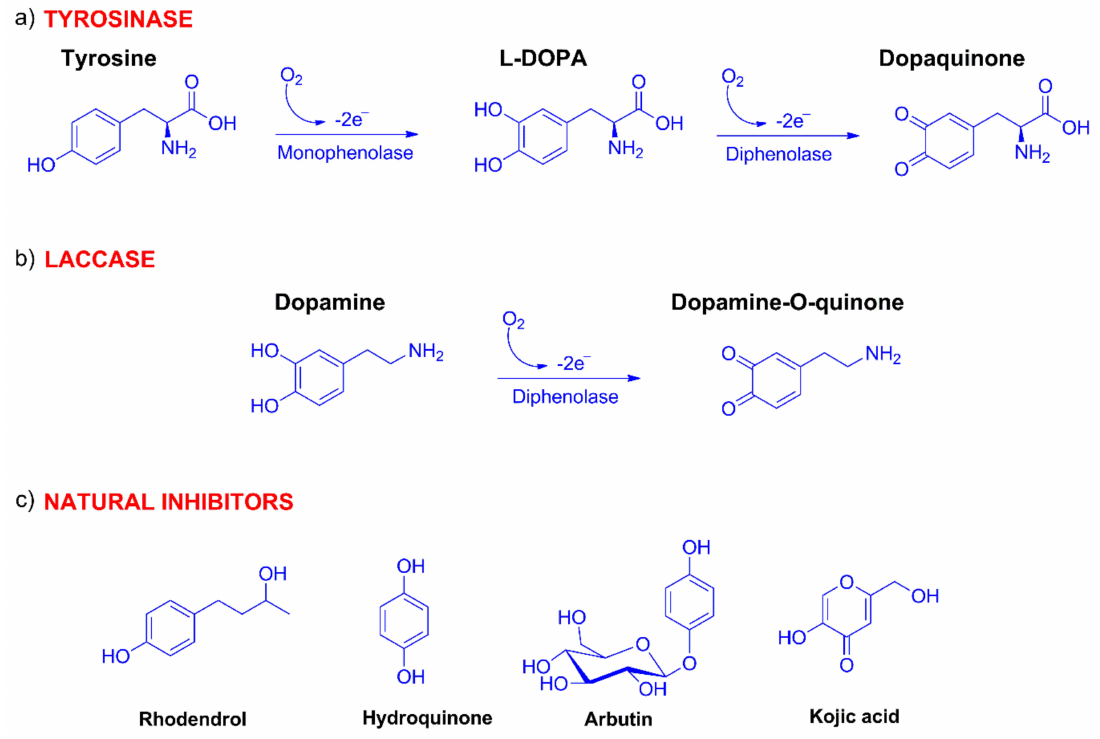
Figure 1. Enzyme reactions of ( a ) tyrosinase and ( b ) laccase and ( c ) natural